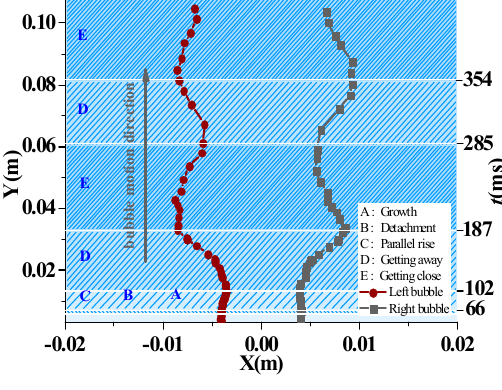
Figure 9. Bubble rising trajectory.